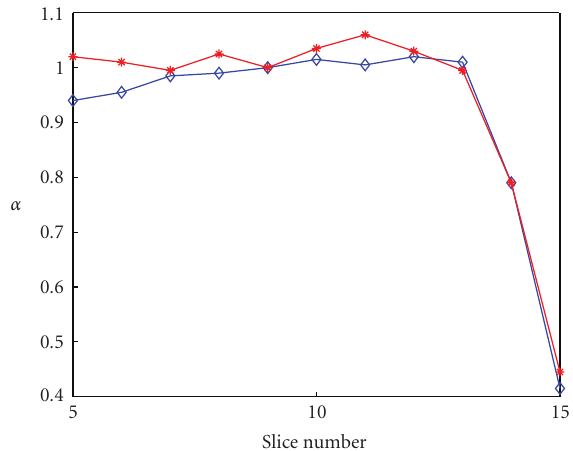
Figure 9: “ α map”: The plot of α value versus slice number for two subjects.